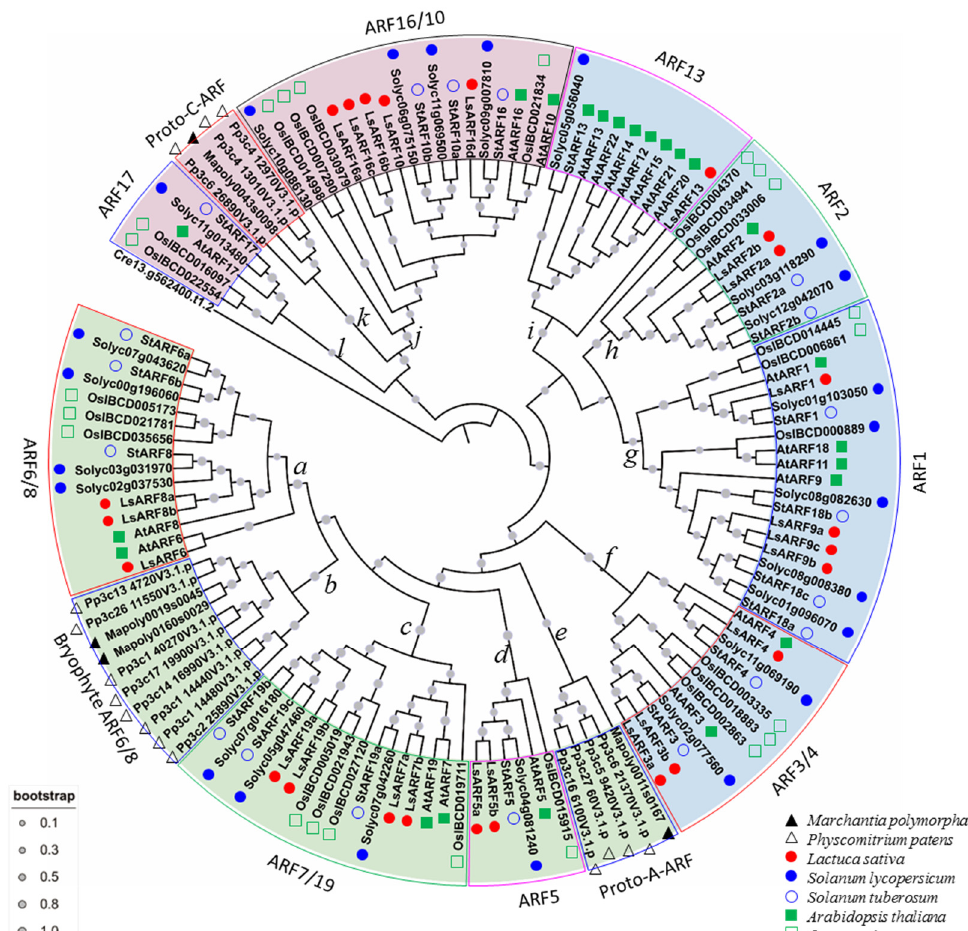
Figure 5. Phylogenetic relationship among ARF proteins from liverwort, moss, tomato, potato, Arabidopsis, rice, and lettuce. The deduced full-length amino acid sequences of ARFs from liverwort, moss, tomato, potato, Arabidopsis, rice, and lettuce were aligned by the MUSCLE method, and the neighbor-joining tree was generated using MEGA X to determine the phylogenetic relationship between those ARF proteins. According to the classification proposed by Mutte et al. (2017), LsARFs were divided into three subgroups: A (purple), B (blue), and C (green). Shadow colors are used to distinguish different LsARF subgroups.